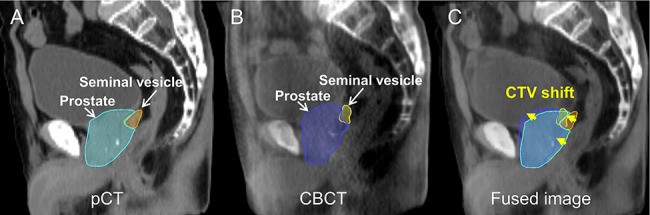
Illustration of the CTV shift of the prostate and seminal vesicle: (A) prostate and seminal vesicle rendered in light blue and orange in the pCT image, respectively, (B) prostate and seminal vesicle rendered in blue and yellow in a CBCT image, respectively, and (C) CTV shift indicated by the yellow arrows in the pCT/CBCT fusion image after an automated bone-based registration.